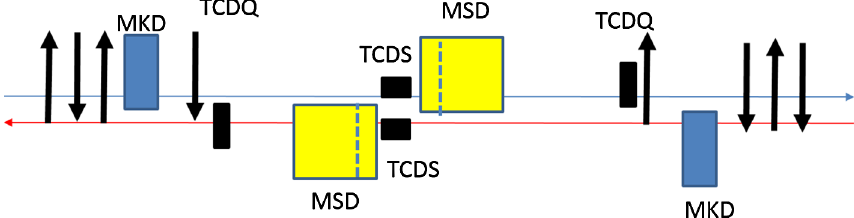
FIG. 7. Layout of the dump concept. Arrows are indicating quadrupoles, MKD and MSD denote the extraction kicker and septum magnets, TCDS and TCDQ the protection absorbers for the septum and the quadrupoles, respectively.